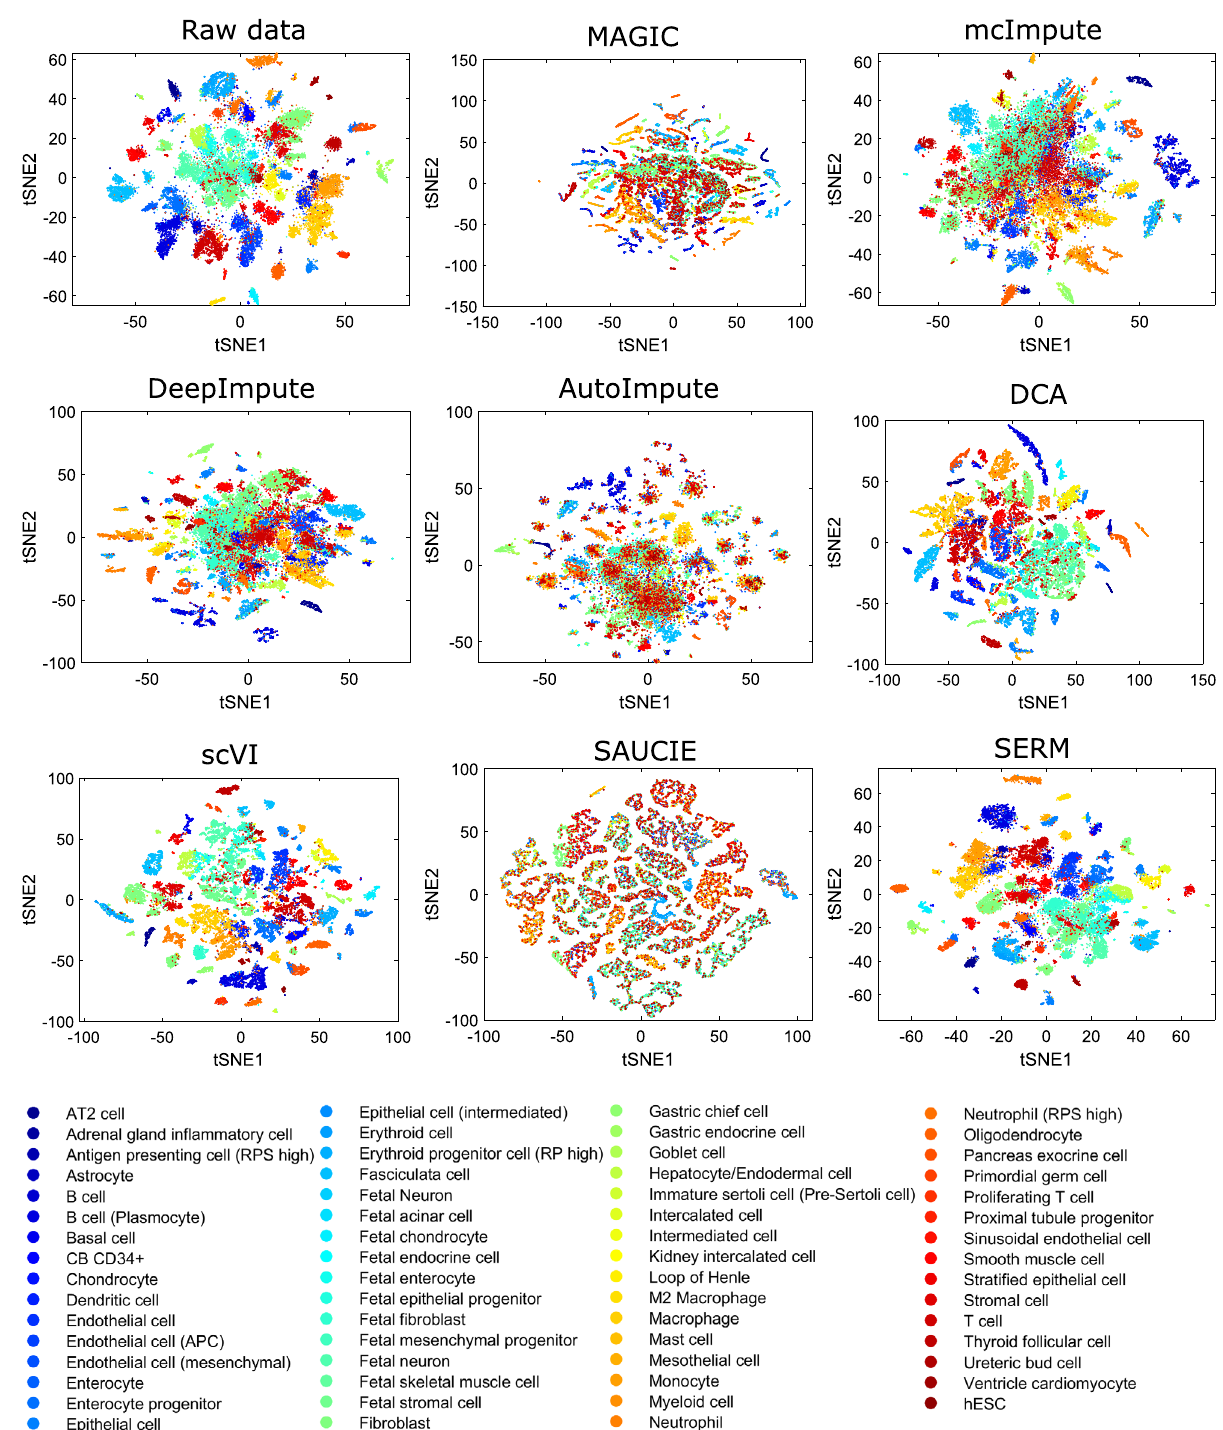
Fig. 8 | t-SNE visualizations of the raw and imputed data by eight different methods for the HCL data. Source data are provided as a Source Data fi